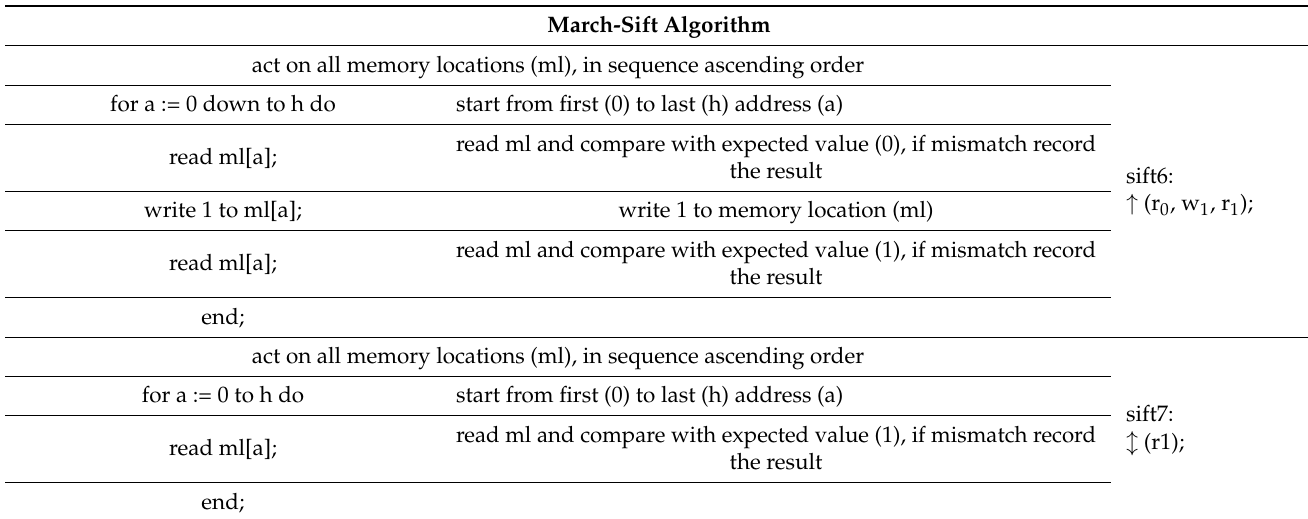
Table 1. Cont. March-Sift